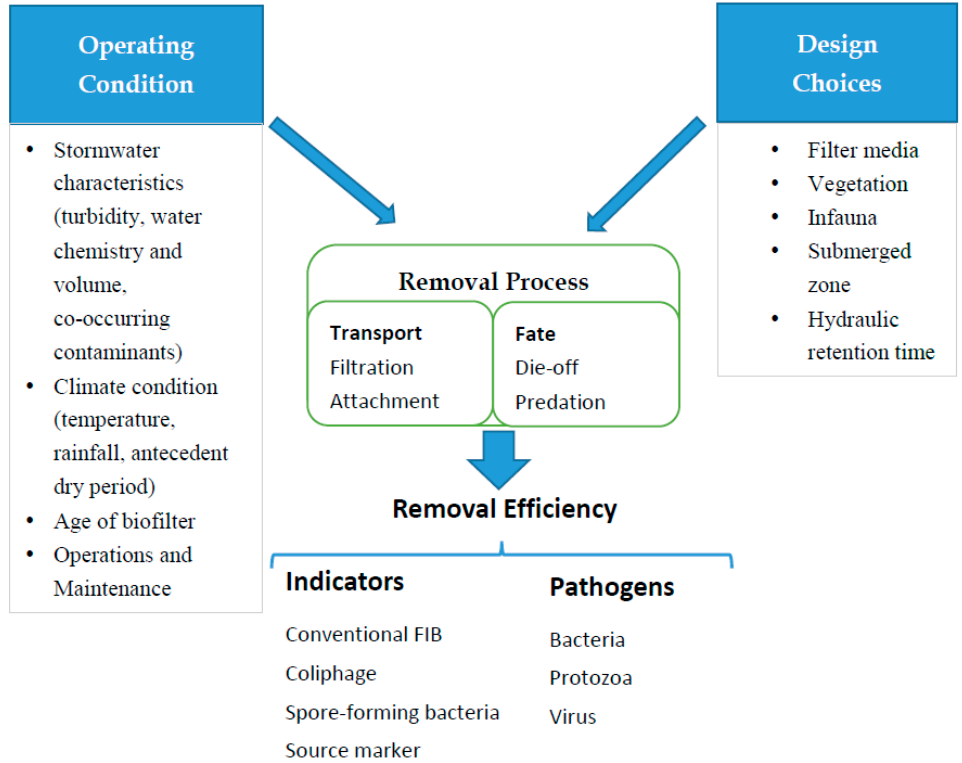
Figure 2. Conceptual model for removal of indicators and pathogens by biofilters. Spore ‐ forming bacteria are usually used as process indicators for protozoan pathogens. Source markers refer to markers (e.g., genetic markers for microbial source tracking that identify fecal sources of microbial contamination).